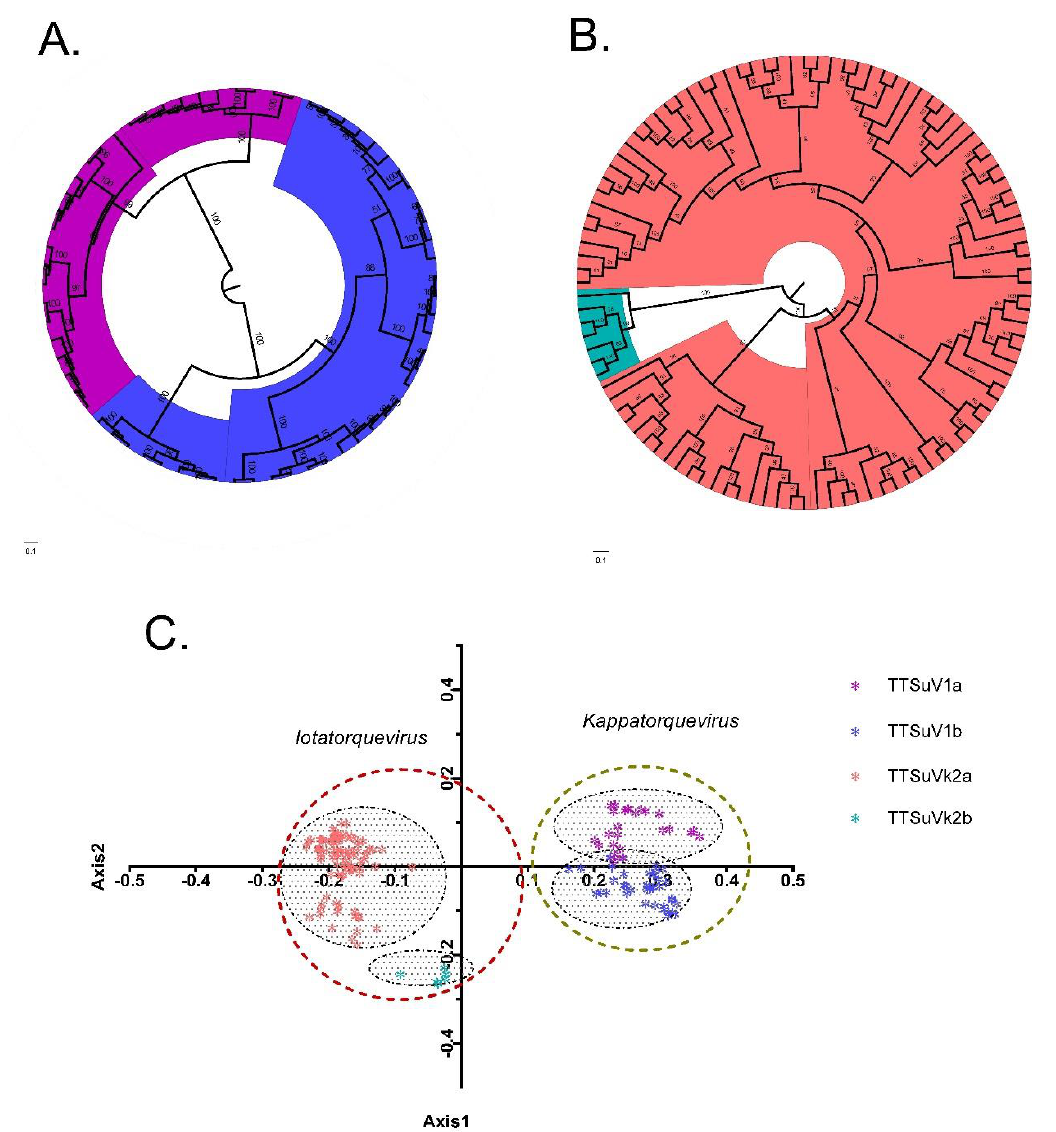
Figure 1. Maximum likelihood (ML) tree of the torque teno sus virus (TTsuV) Iotatorquevirus (TTSuV1) ( A ) and Kappatorquevirus (TTSuVk2) ( B ) reconstructed by RAxML (v8.2.10). Principal component analysis (PCA) in terms of codon usage pattern ( C ). TTSuV1a, TTSuV1b, TTSuVk2a, and TTSuVk2b are represented in purple, blue, pink, and green, respectively.